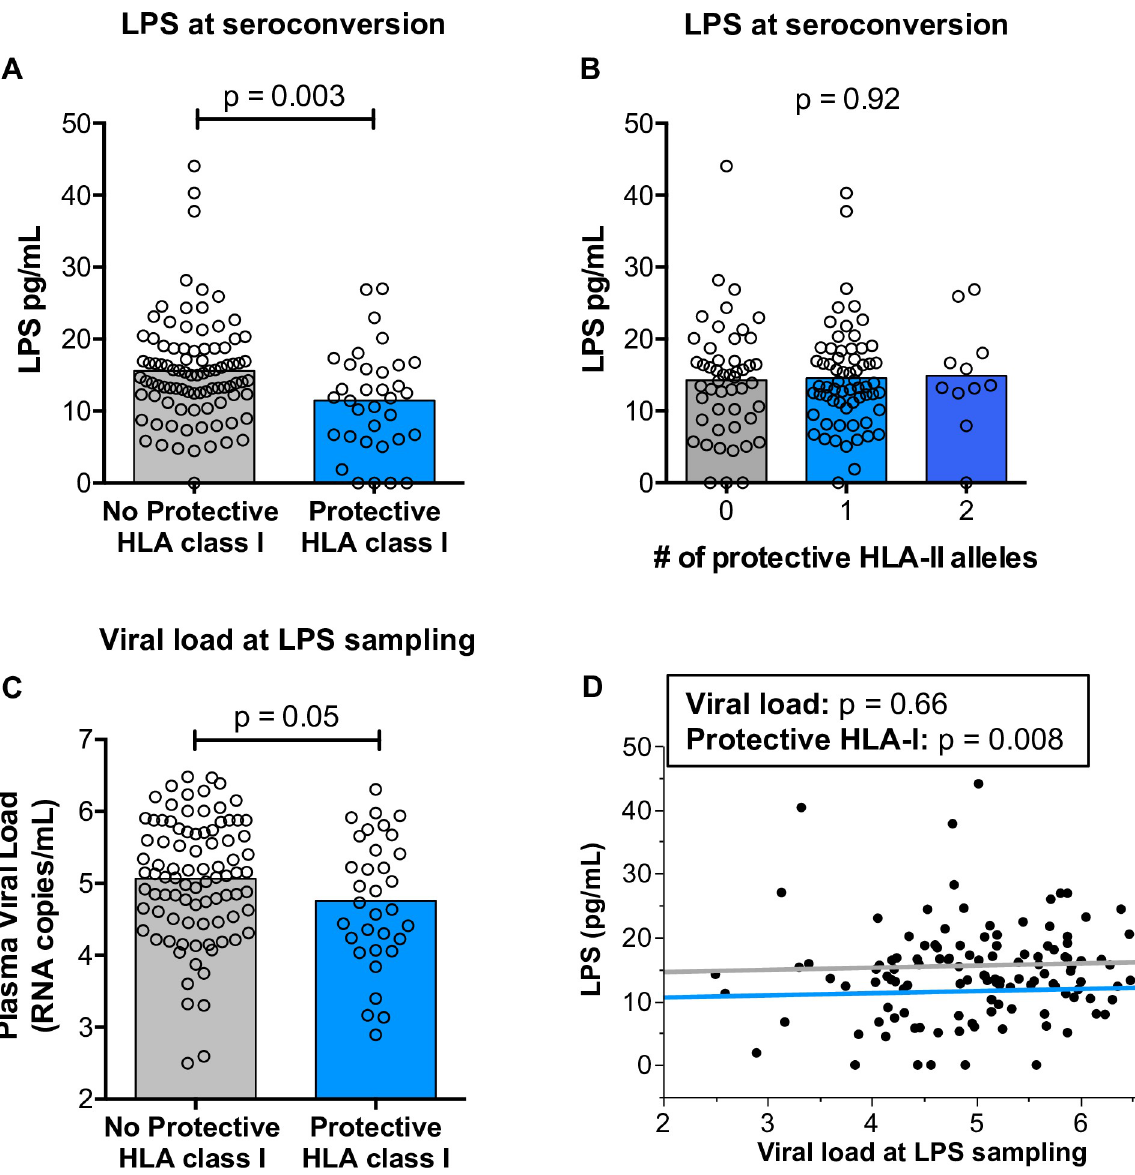
Fig 2. Protective HLA class I, but not HLA class II, alleles are associated with reduced levels of circulating lipopolysaccharide early after HIV infection. Lipopolysaccharide (LPS) levels were measured in the plasma for 124 seroconvertors a median of 44 days after the estimated date of infection. (A and B) The levels of LPS in the plasma were compared between individuals carrying any of the defined protective HLA class I (panel A) or HLA class II alleles (panel B). Statistical comparisons were made using the Student’s t test (A and C) or an ANOVA (B) and reported p-values are one-tailed. (C) Comparison of viral load at the time of LPS measurement between individuals with or without protective HLA class I alleles. (D) A graphical depiction of a generalized linear model showing the relative associations between both plasma viral load and the presence of protective HLA class I alleles with LPS levels measured in the plasma. The distance between horizontal lines represent the difference in means between individuals with (light blue) and without (gray) protective HLA class I alleles whereas the direction of the lines represents regression between the two continuous variables: viral load (x-axis) and LPS in the plasma (y-axis).